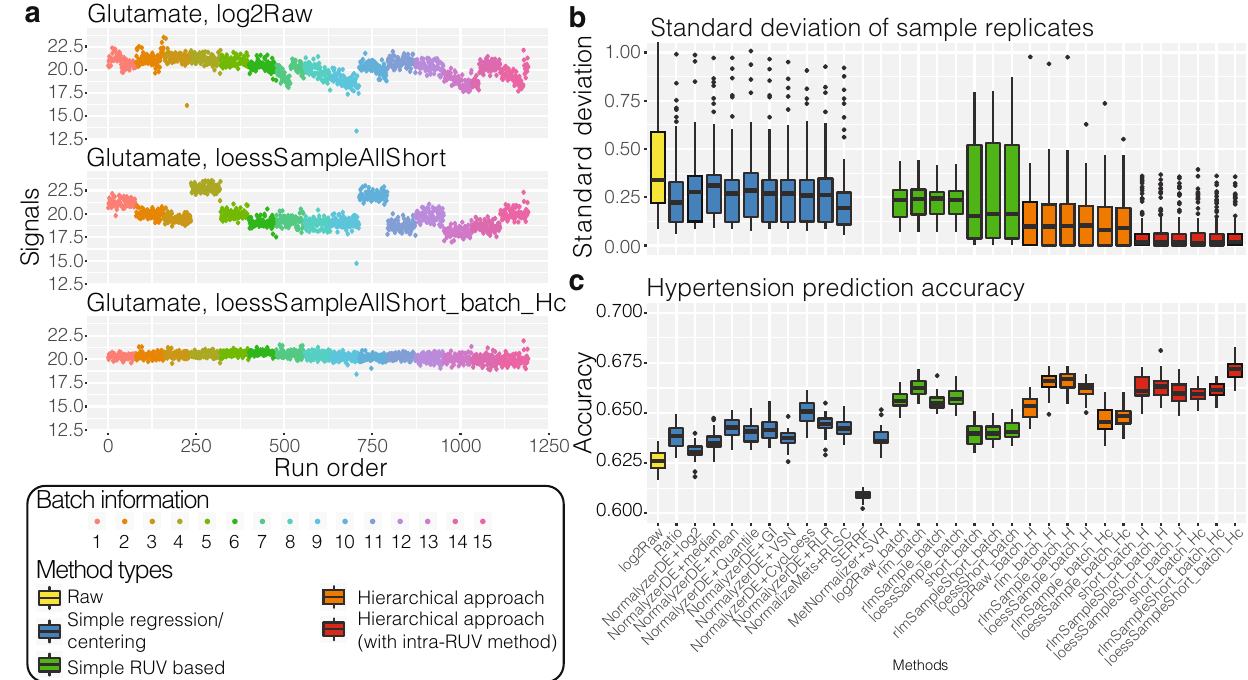
Fig. 3 Key assessments of hRUV performances. a A run plot of raw, intra-batch-corrected and fi nal hRUV normalised data in all 15 batches of the BioHEART-CT cohort. The x axis indicates the run order, the y axis indicates the signal of glutamate, and samples are coloured by the batch numbers. b Boxplots of all sample replicate ( n = 175 sample replicates) standard deviations, where lower values indicate better performance. The boxes are coloured by the approach taken to normalise the data. The y axis of the plot is restricted to a range between 0 to 1 to highlight the differences between the majority of the methods. SERRF and MetNormalizer + SVR ’ s median sample replicate SD was >1 and thus is not shown. c Boxplots of hypertension prediction accuracies ( n = 30 repeats) for all methods. Higher prediction accuracy indicates better performance. The colouring of the boxes are consistent with that in b . In b , c , the box indicates quartiles and the whiskers indicate the rest of the distribution, with outliers shown as dots. Source data are provided as a Source data fi